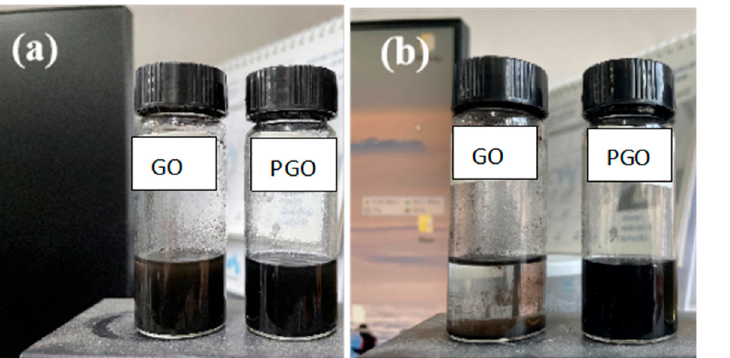
Figure 5. Digital photos of dispersion of GO and PGO in n-butanol: ( a ) just after ultrasonic irradiation and ( b ) after 15 min of standing.